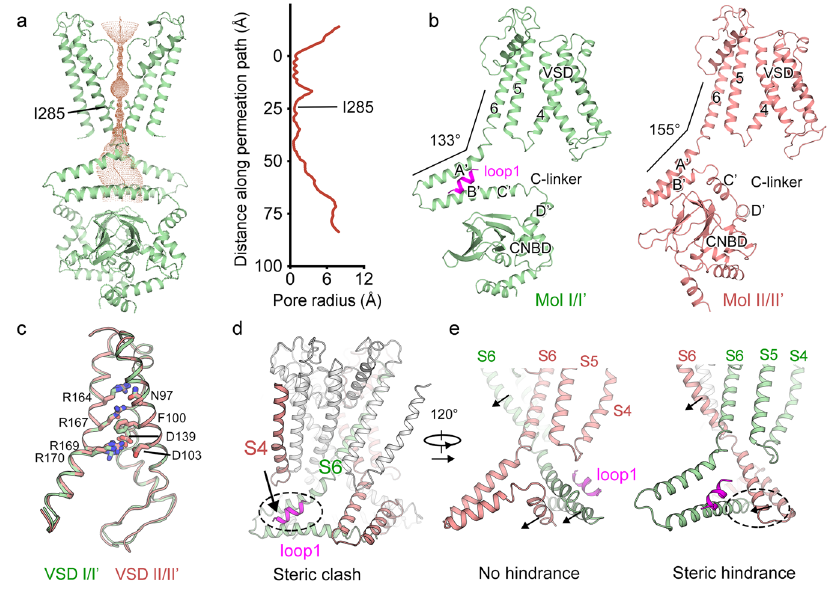
Fig. 2 | Different conformations of C-linkers lead to the steric hindrance for AKT1 activation. a Radius of the pore calculated by the HOLE program 52 . The amino acids restricting the inner gate are shown in sticks. b Different conforma- tions of Mol I/I ’ (left) and Mol II/II ’ (right). c VSDs of all four subunits share similar